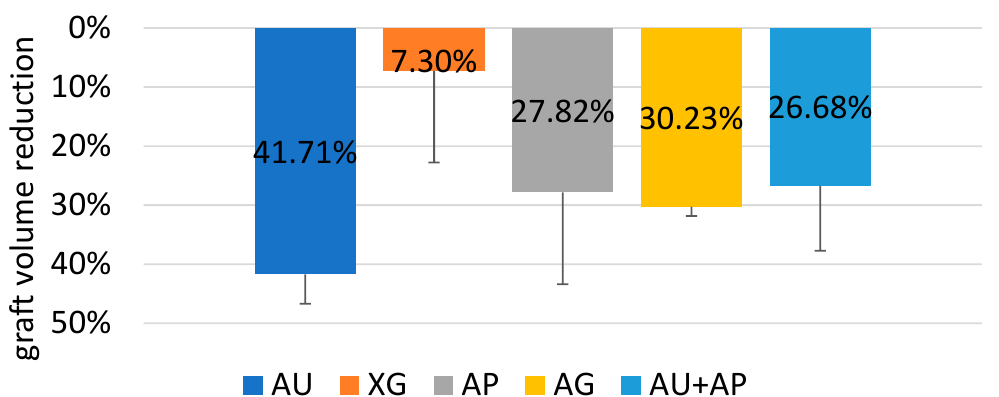
Figure 7. Percentage reduction for each biomaterial .